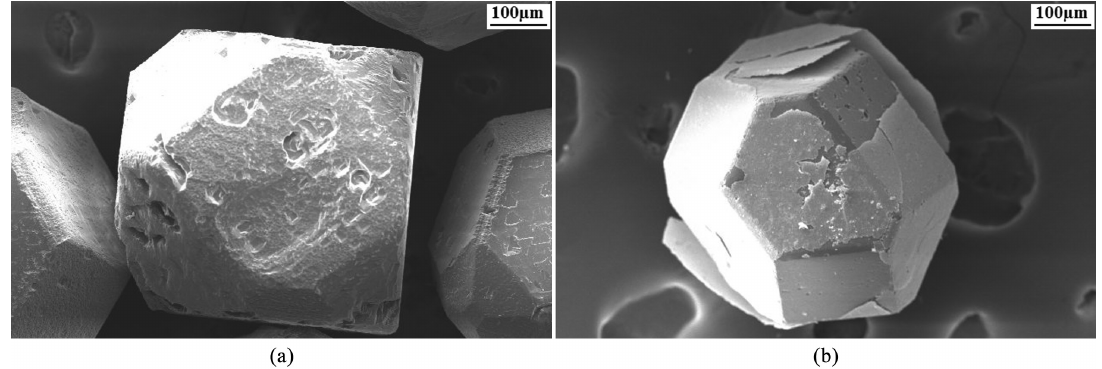
Figure 9. Diamonds (a) without coating and (b) with Ti coating, after heat treatment during 180 min.